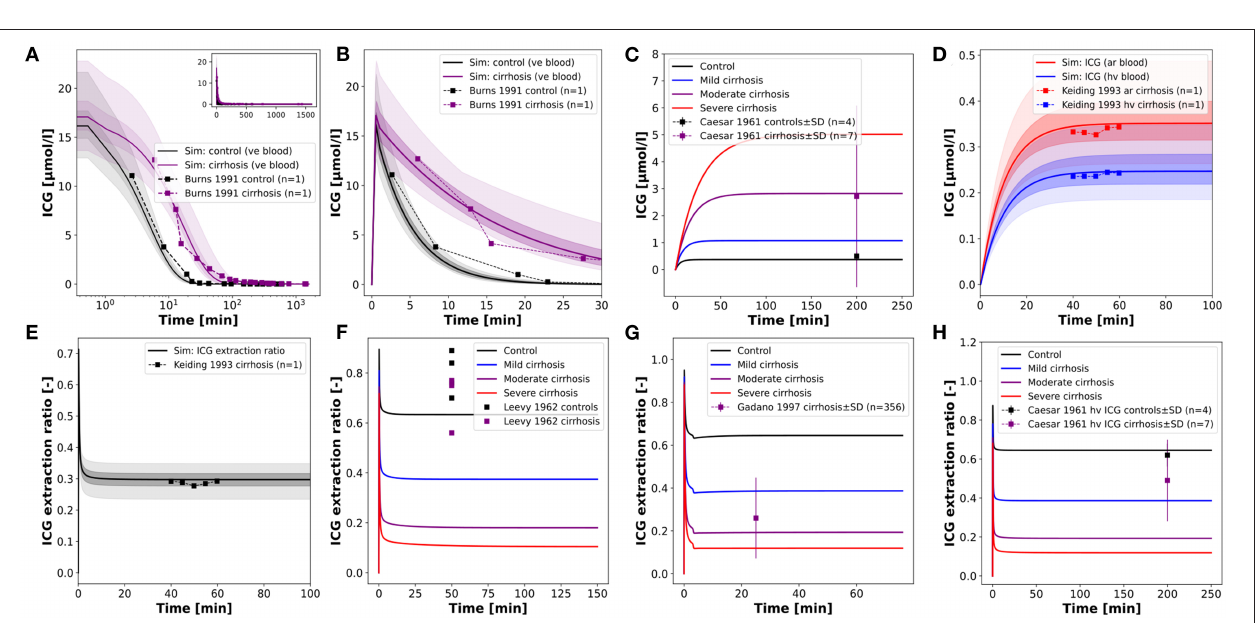
FIGURE 6 | Model prediction of ICG time courses in subjects with cirrhosis. (A,B) Venous concentration after a bolus ICG administration in a healthy subject and a cirrhotic patient ( f cirrhosis was set to 0.7 corresponding to moderate cirrhosis) (Burns et al., 1991). (C) Venous concentration during a constant ICG infusion in healthy and cirrhotic subjects (Caesar et al., 1961). (D,E) Hepatic venous and arterial ICG concentration and ICG extraction ratio in a cirrhotic patient ( f cirrhosis was set to 0.54 corresponding to mild-moderate cirrhosis) (Keiding et al., 1993). (F–H) ICG extraction ratio in cirrhotic and control subjects during a constant ICG infusion (Caesar et al., 1961; Leevy et al., 1962; Gadano et al., 1997).